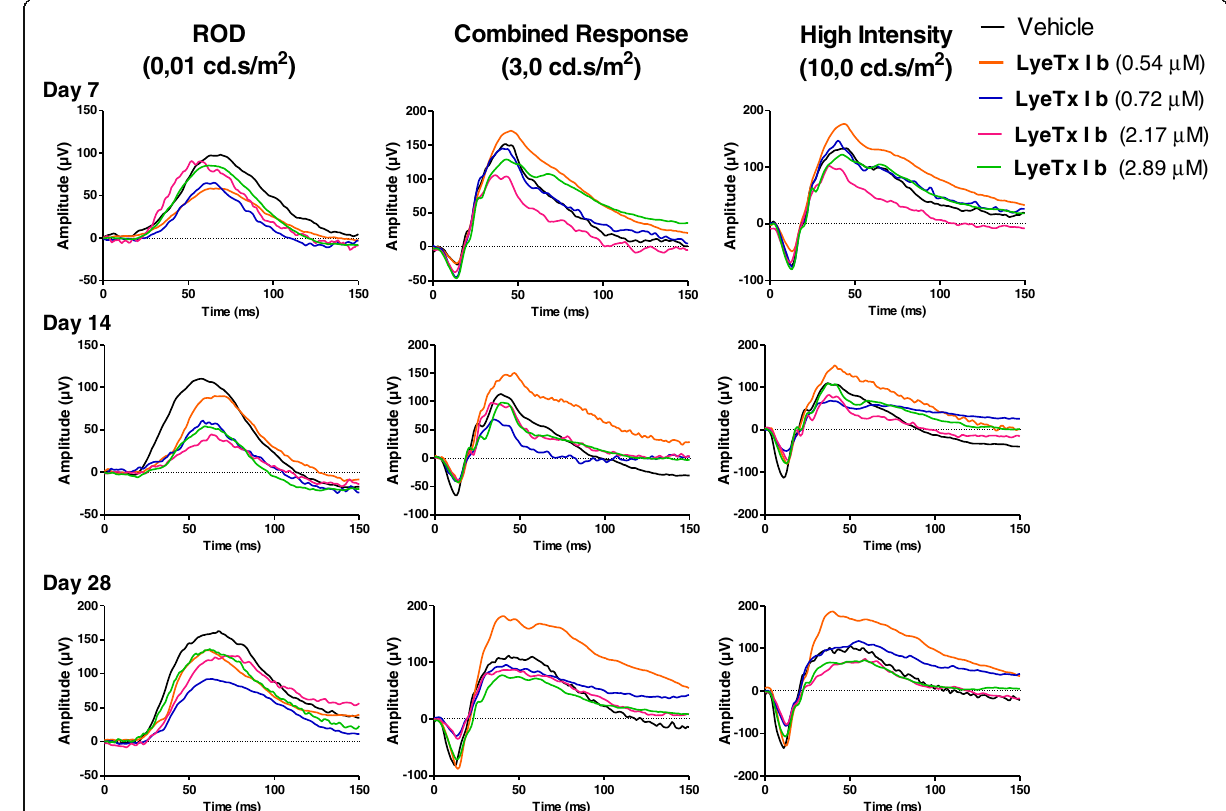
Fig. 4 Representative ERG recordings of rabbit ’ s eye injected with different doses of LyeTx I b at different time points darkness-adapted (0.01, 3.0 and 10 cd.s/m 2 )